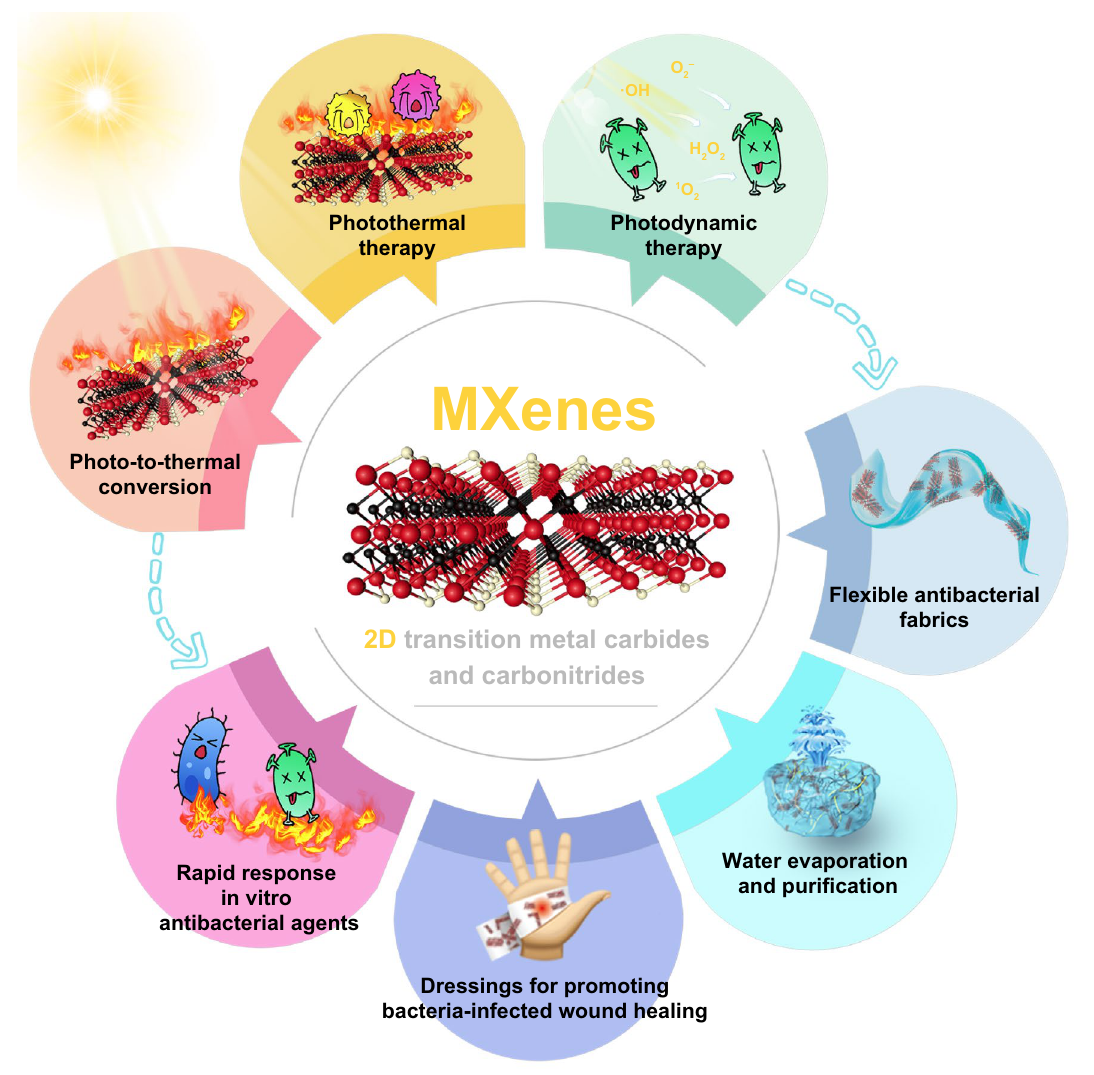
Fig. 1 The effective photothermal antibacterial performances of MXenes endow them with widespread application